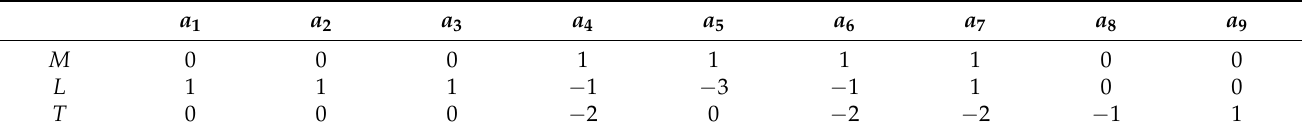
Table 3. Dimensional